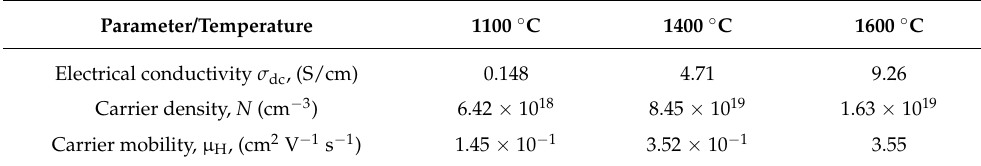
Table 3. Electrical properties of the carbon-rich SiCN